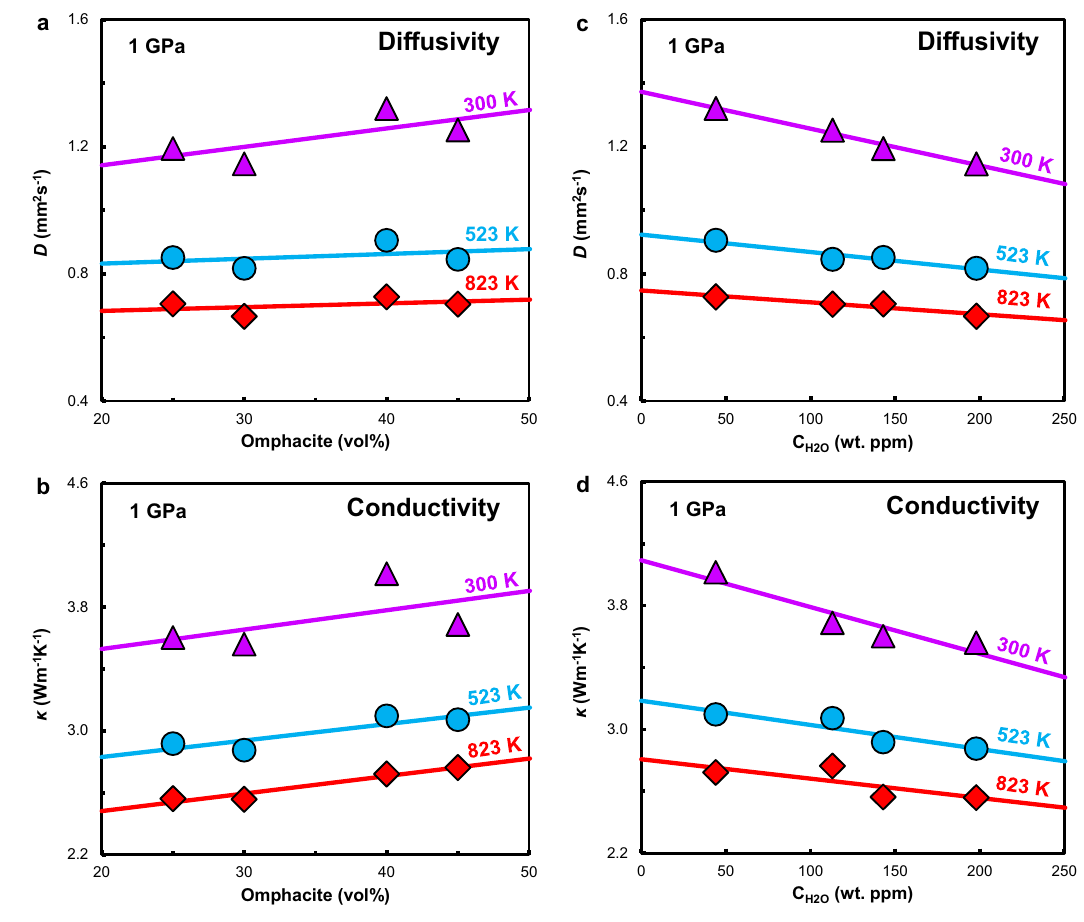
Fig. 2 | Effects of modal mineralogy and water content on the thermal prop- erties of eclogite at 1GPa and 300 – 823K. a Effect of omphacite proportion on the thermal diffusivity ( D ). b Effect of omphacite proportion on the thermal